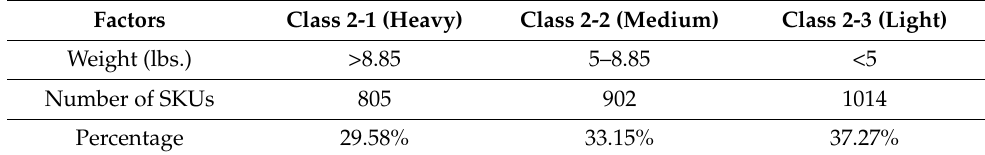
Table 3. Weight-based classes for Scenario